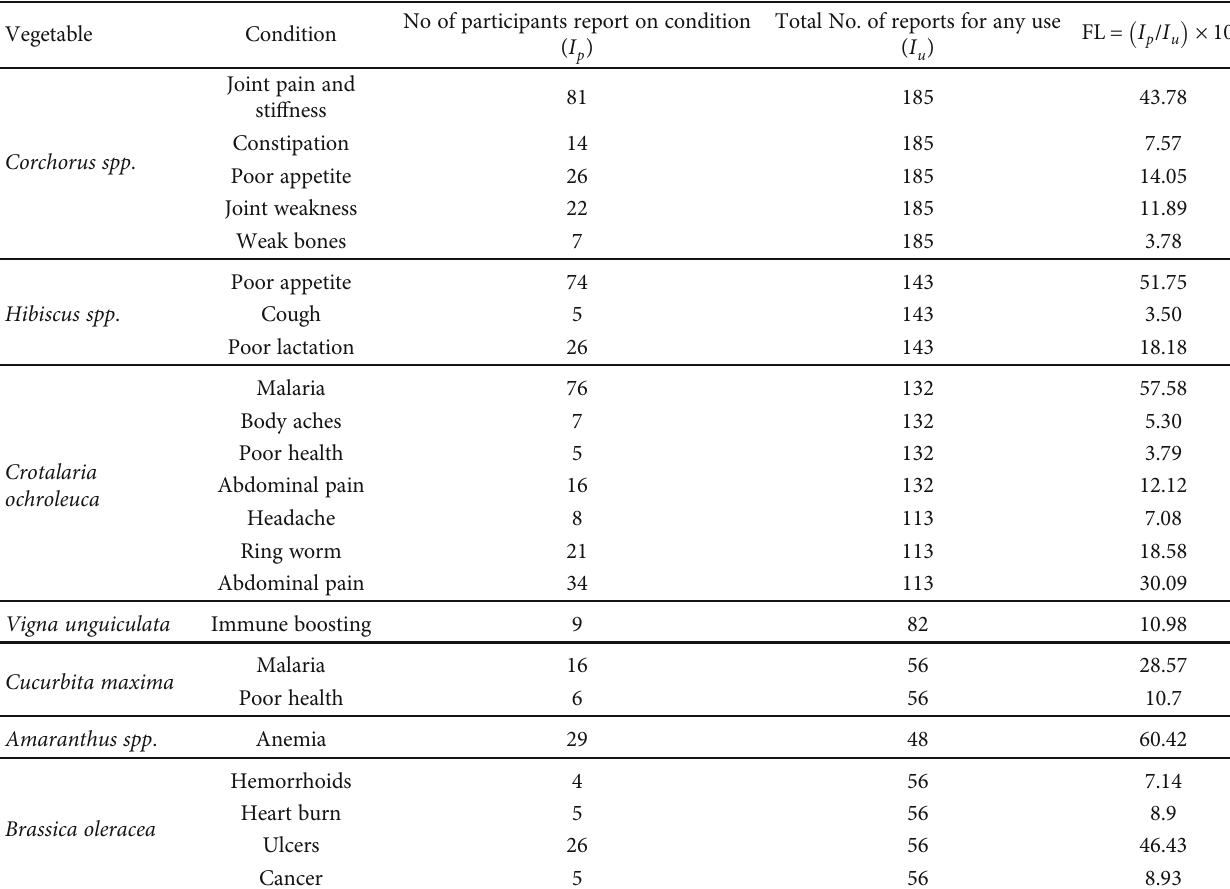
Table 4: Fidelity levels of the most common medicinal vegetables.